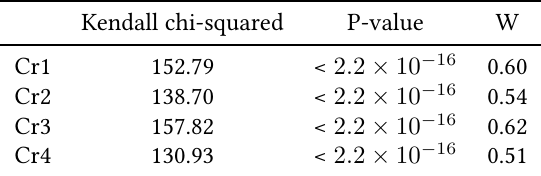
Table 4 Generalized data for calculating the concordance coefficient W for criteria.